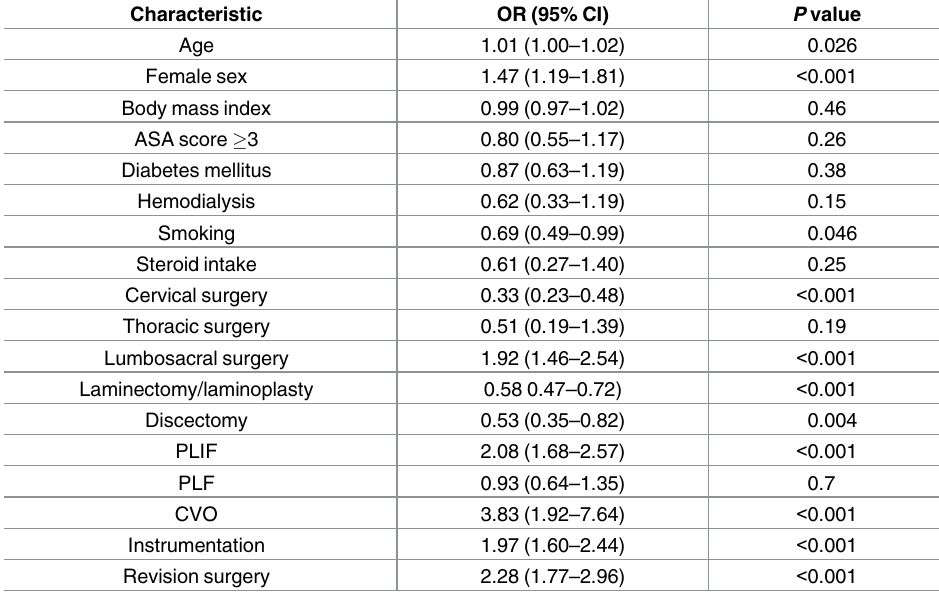
Table 2. Univariable logistic regression analysesfor ID during posterior open spine surgery.